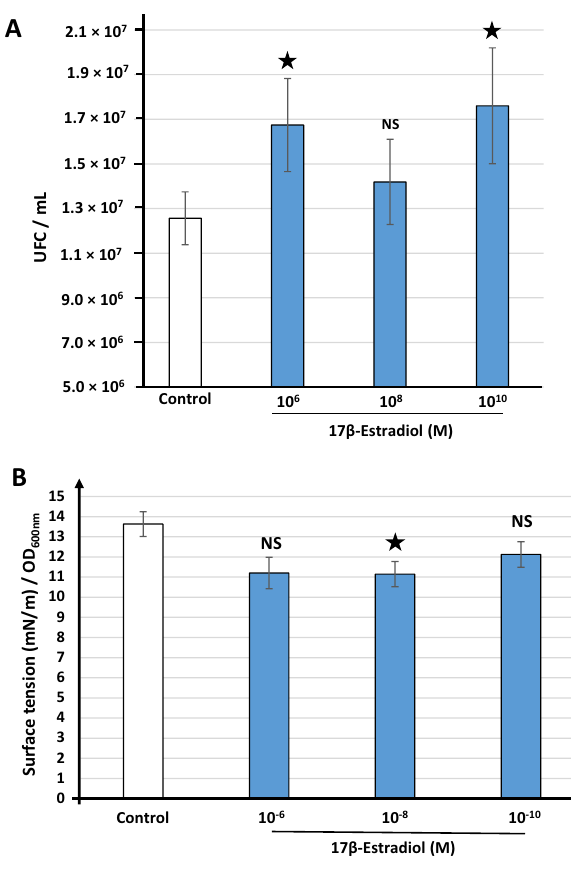
Figure 7. Effect of 17β-estradiol on Lactobacillus crispatus V4 adhesion to human VK2/E6E7 vaginal cells and biosurfactant production. ( A ) Effect of 17β-estradiol on the adhesion potential of Lactobacillus crispatus V4 grown in MRS medium to human VK2/E6E7 vaginal cells. ( B ) Surface tension of the water solution extracted from L. crispatus V4 cultures exposed or not to 17β-estradiol (10 –6 , 10 –8 , or 10 –10 M) calculated from analysis of the curvature of hanging drops. The absence of an effect of 17β-estradiol on surface tension was controlled in preliminary studies. Values are the means ± SEM of three independent studies ( NS not significant,